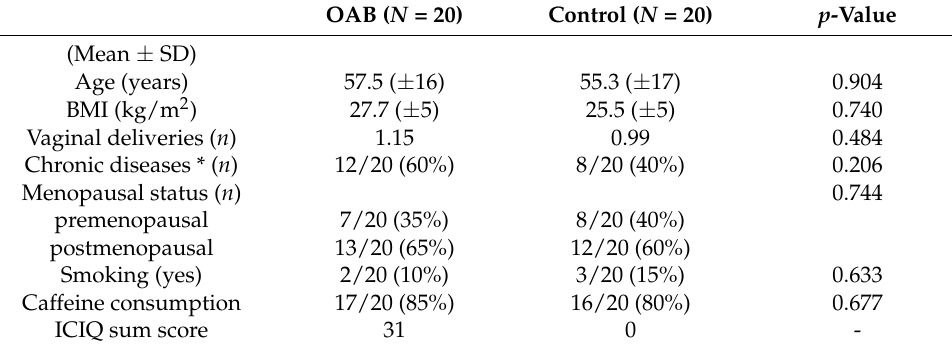
Table 1. Demographic data.